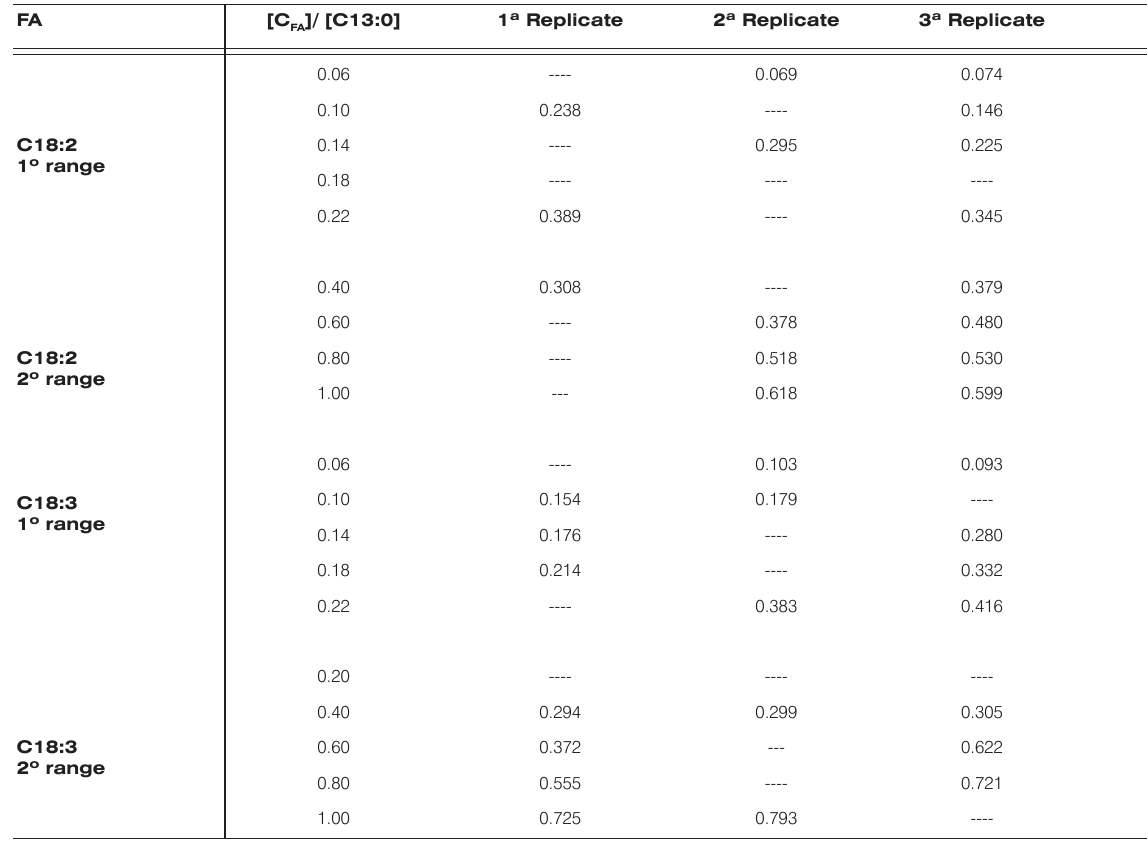
Table 2. Values used to regression model implementation with genuine replicates.